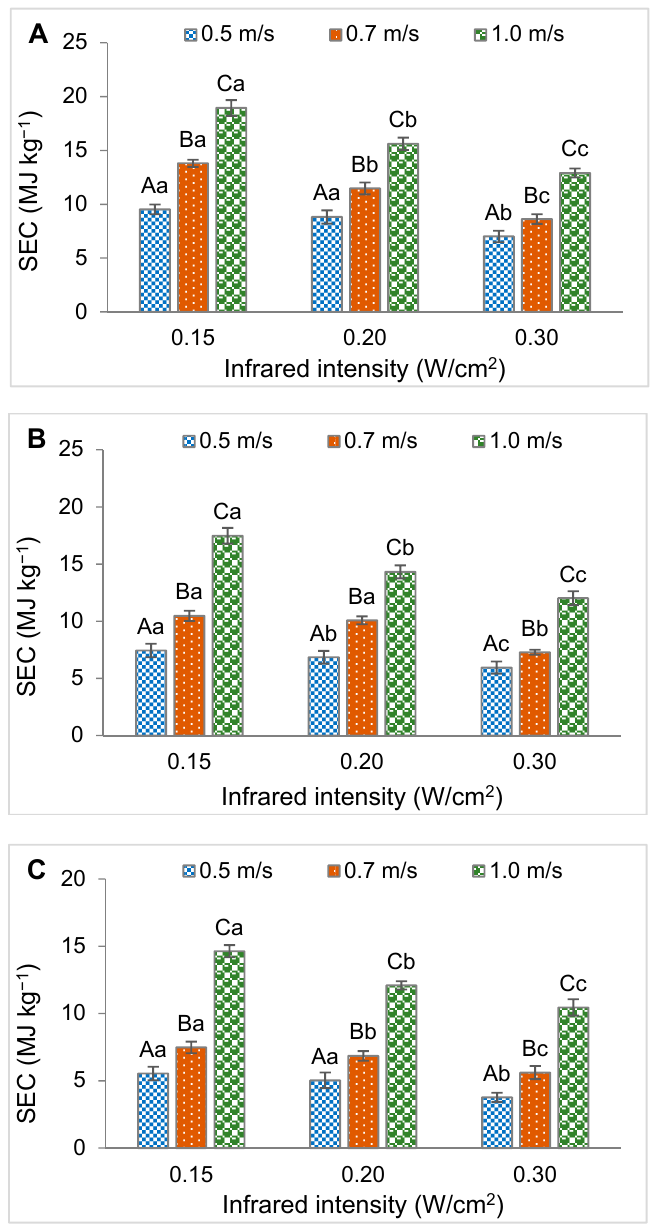
Figure 5. The effect of infrared intensity at different air velocities on the specific energy consumption Figure 5. The e ff ect of infrared intensity at di ff erent air velocities on the specific energy consumption